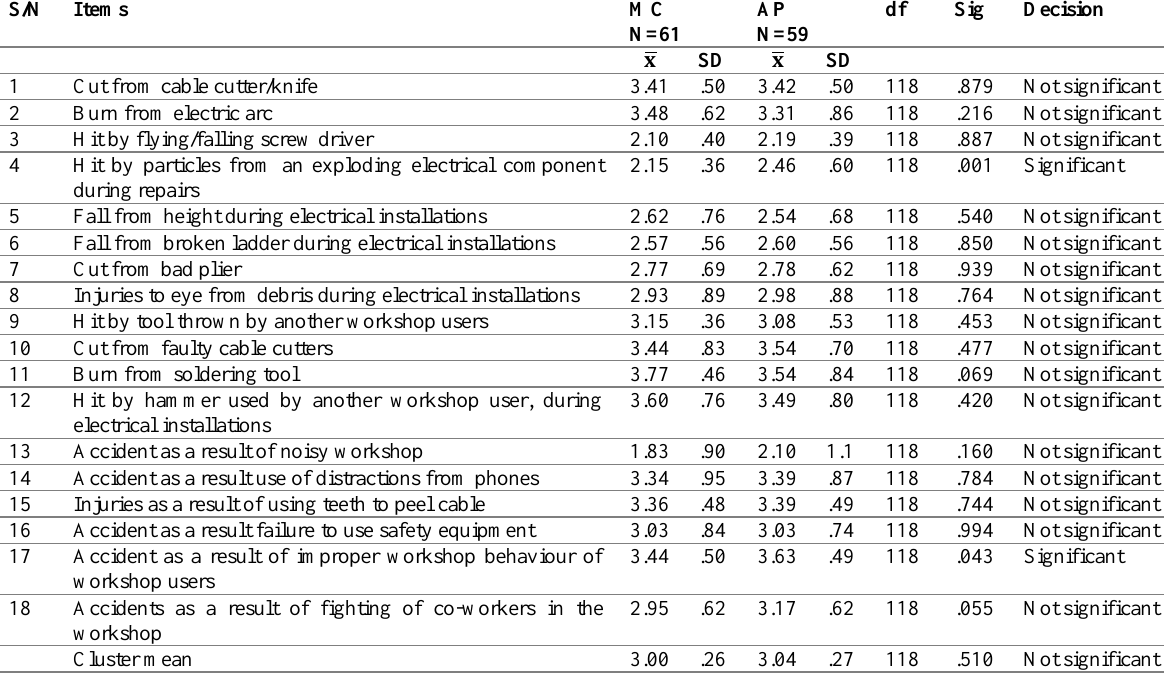
in the Electrical/Electronics Workshop.